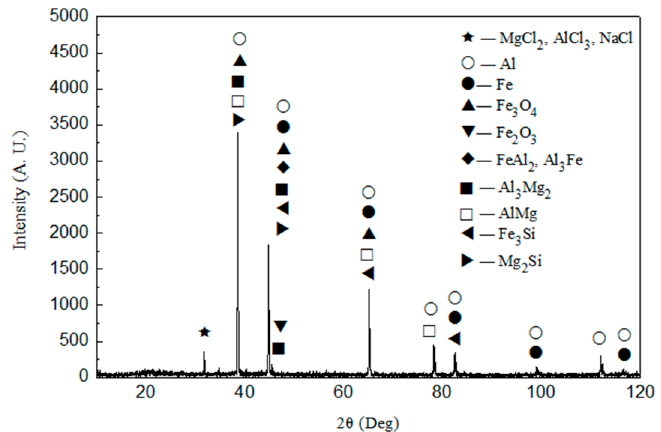
Figure 8. XRD (X-ray Diffraction) spectrum of the transverse section of keyhole-free FSSW joints of dissimilar 6082 aluminum alloy and DP600 galvanized steel.